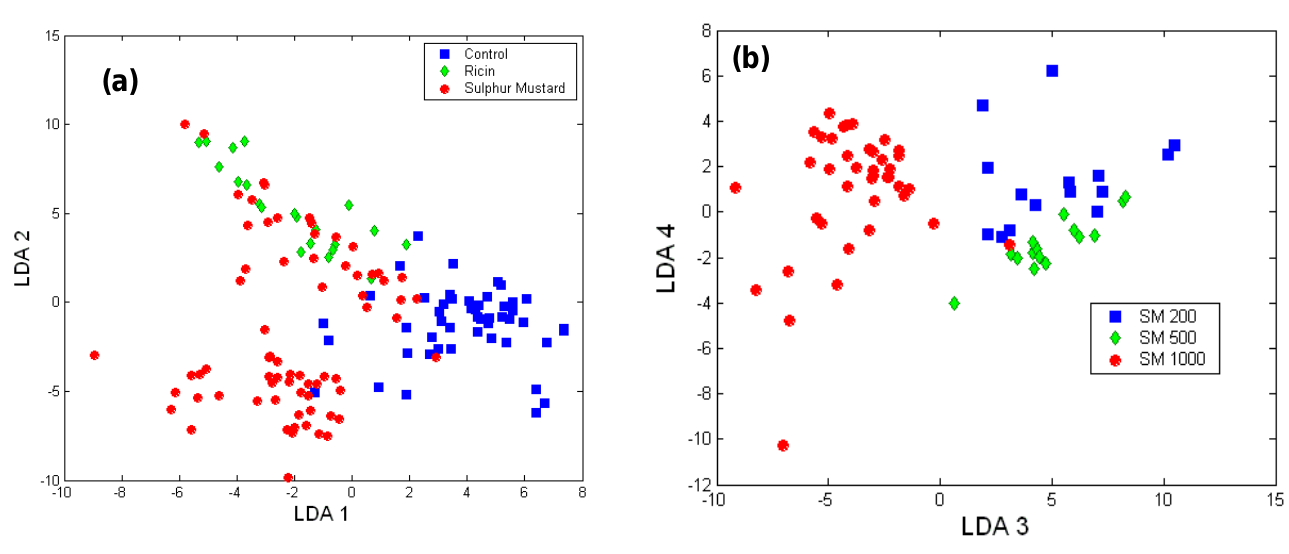
Figure 7 . Scores of LDA model for (a) A549 cells exposed to ricin and sulphur mustard and (b) A549 cells exposed to various concentrations of sulphur